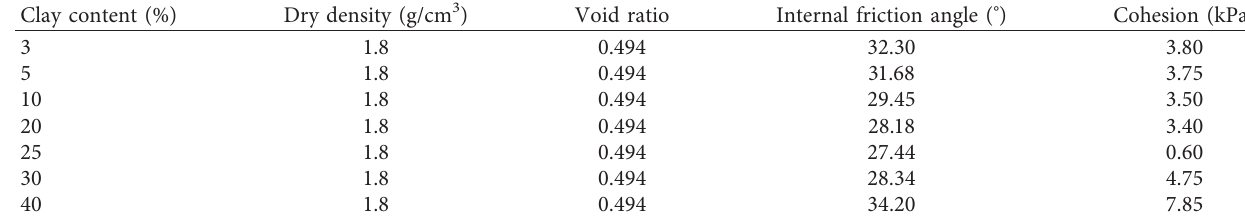
Table 4: Properties of sandy silt and direct shear test results.